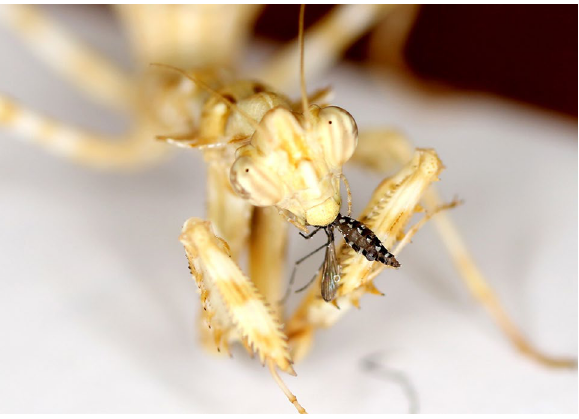
Figure 8. Blepharopsis mendica eating a female Aedes mosquito. (Photo credit: Wallner